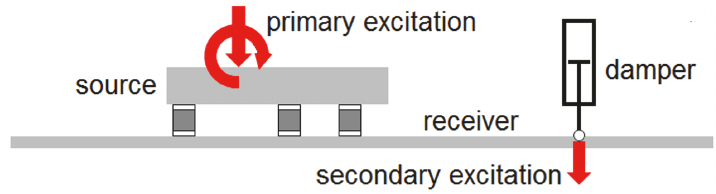
Figure 8: System source-receiver.